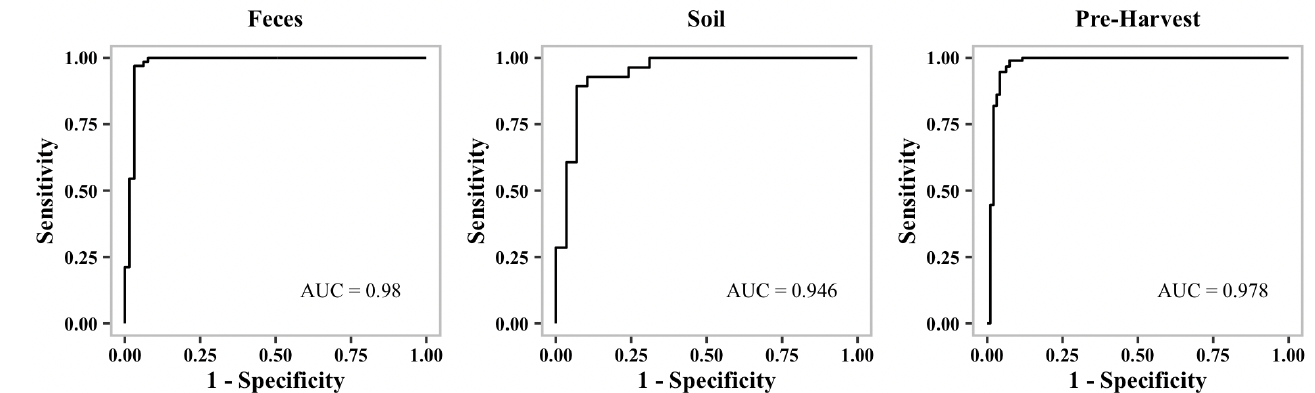
Figure 2. Receiver operating characteristic curve (ROC curve) of Campylobacter MDR models.